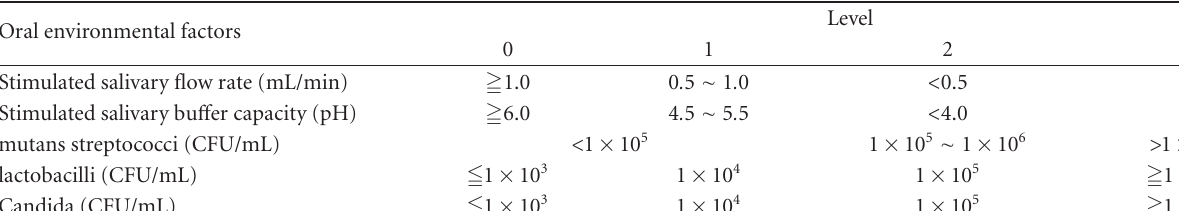
Table 1: Classification of oral environmental factors.